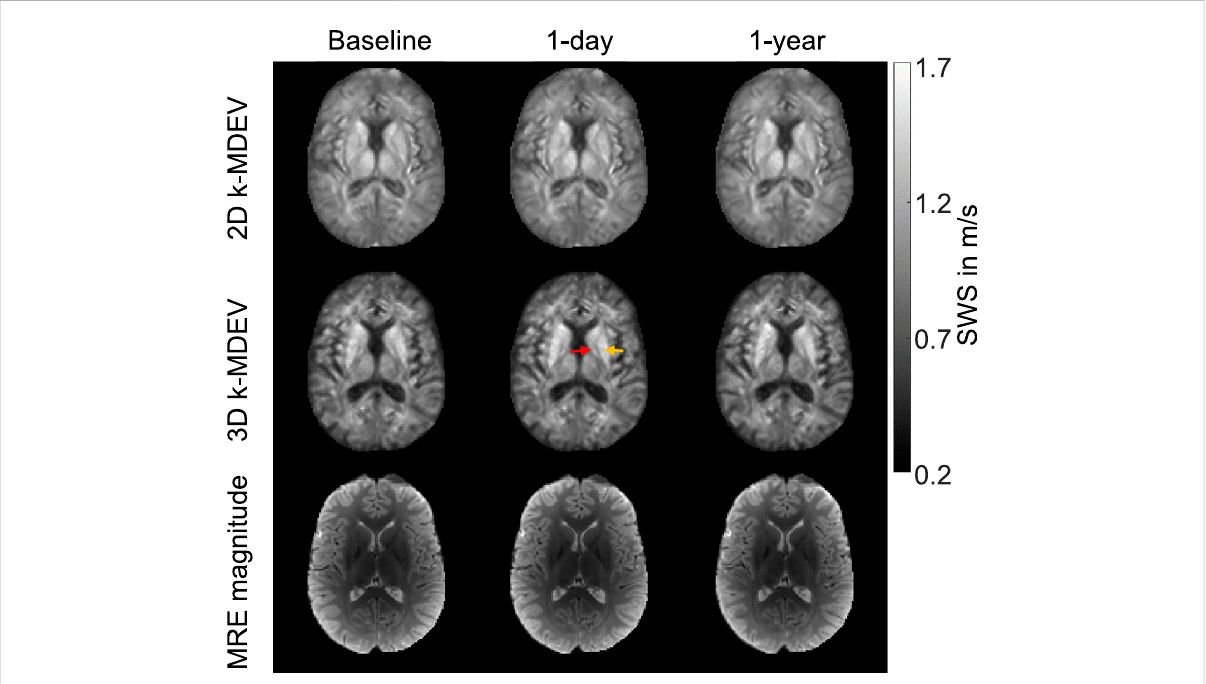
FIGURE 5 Representative MRE stiffness maps and magnitude images from one volunteer examined at three time points: baseline, 1 day later (1-day), and 1 year later (1-year) for 2D (top) and 3D k -MDEV-based reconstruction (bottom). The red arrow points to globus pallidus while the yellow arrow points to putamen. Both regions are clearly distinguishable by eye, consistent with distinct group-averaged